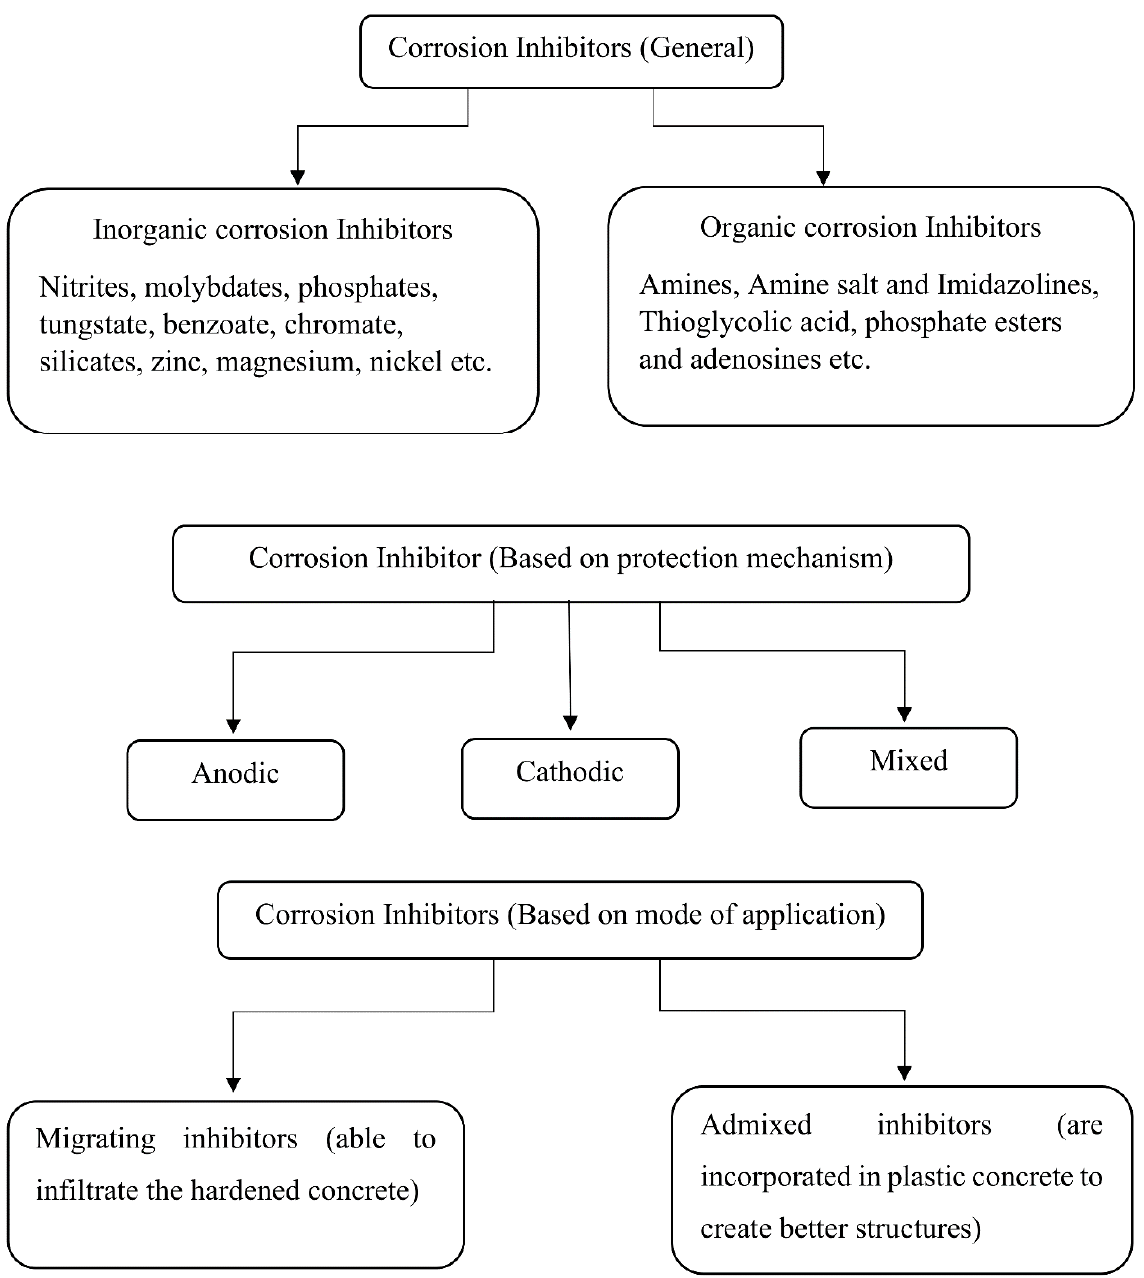
Figure 2. Classification of Corrosion Inhibitors.